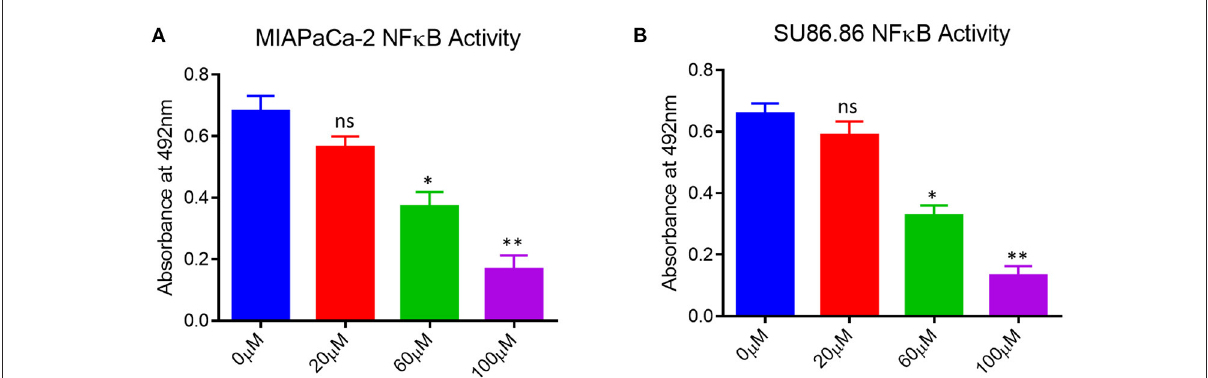
FIGURE5 NF- κ B activity in untreated (0 µ M) and treated (A) MIAPaCa-2 (B) SU 86.86 with various concentrations of EGCG (20, 60, and 100 µ M) cells. MIAPaCa-2 and SU 86.86 cells were seeded at a density of 10 5 /well in 24-well plates and induced with EGCG (20, 60, and 100 µ M) for 24h. Levels of p65-NF- κ B activity were up-regulated in untreated human pancreatic cancer cells, and EGCG treatment reduced the p65-NF- κ B activity in both pancreatic cell lines at 60 and 100 µ M. Results are expressed as a percentage of control and mean ± SD ( n = 4). * p < 0.05, ** p < 0.01, vs. untreated cells.